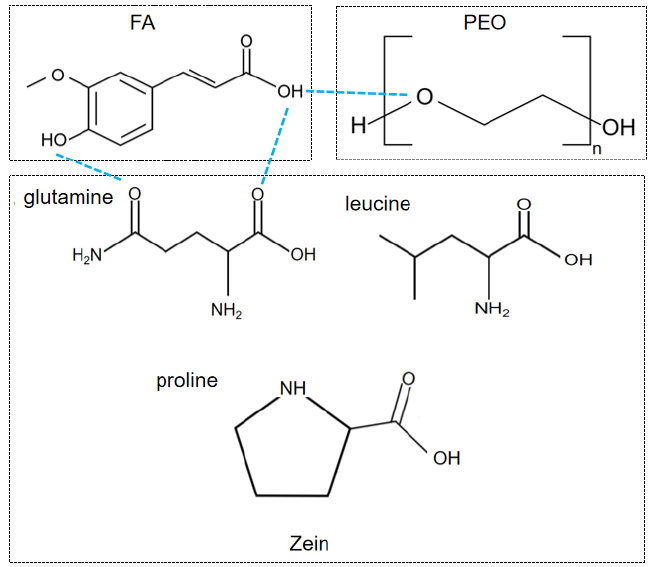
Figure 7. The molecular formulas of zein, PEO, and FA.